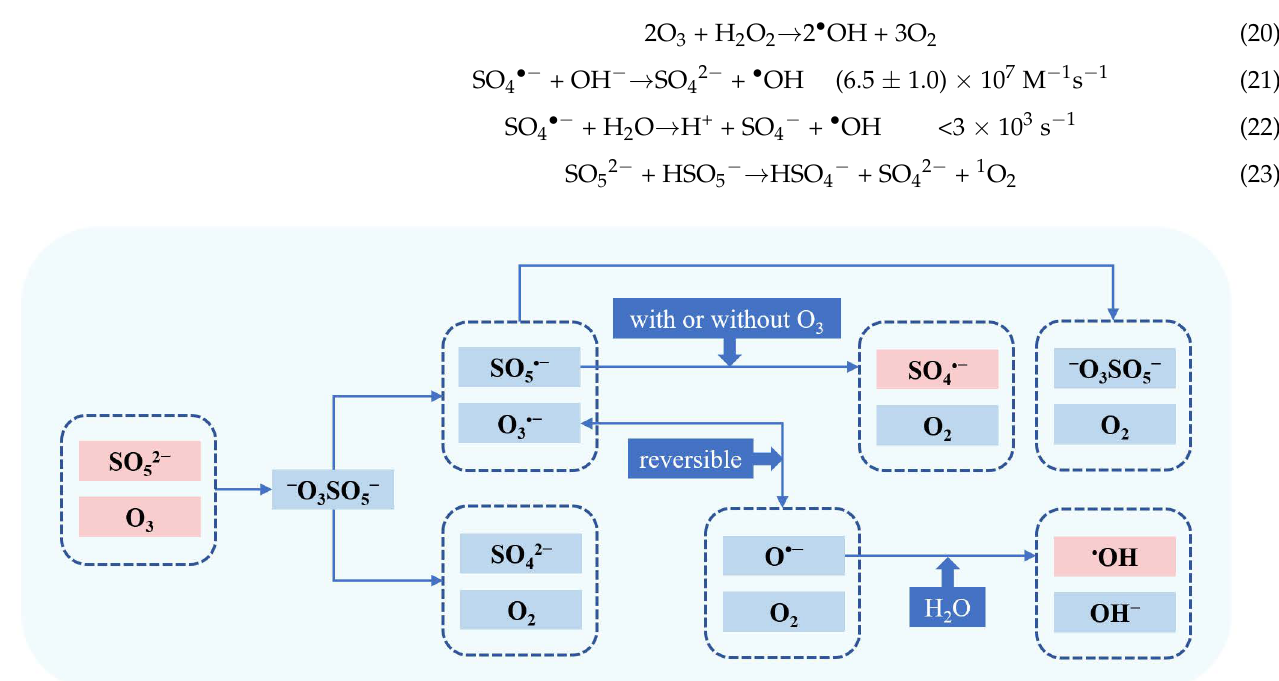
Figure 2. The mechanism of the simultaneous production of • OH and SO 4 •− in the O 3 /PMS system.